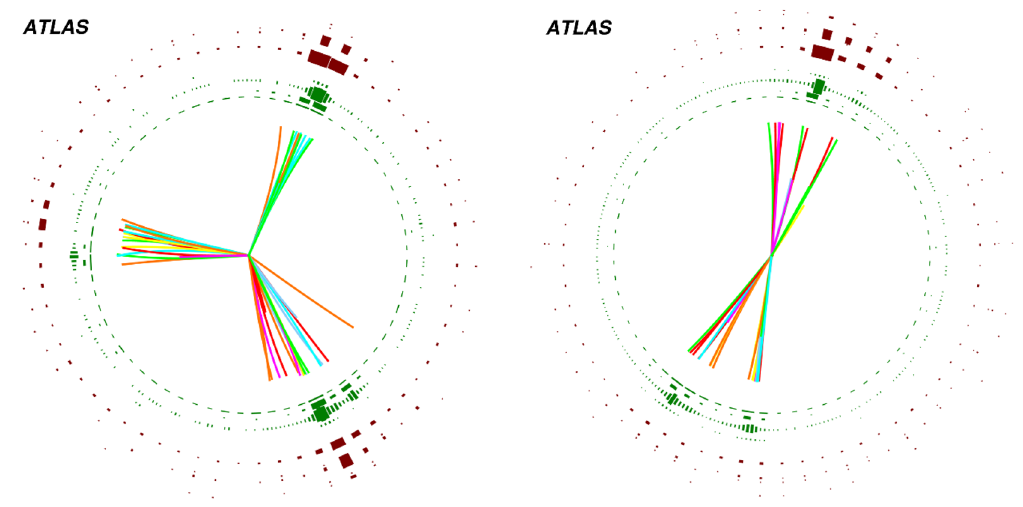
Figure 1 . Transverse plane projection of a three-jet event with high values of τ ⊥ and S ⊥ (left), and a five-jet event with low values τ ⊥ and S ⊥ (right). The colours are chosen for illustrative